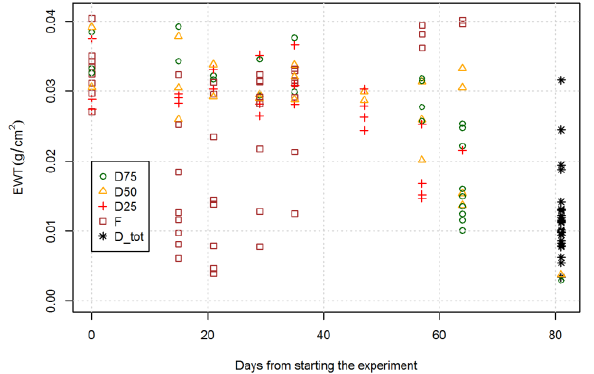
Figure 1. Equivalent water thickness (EWT) in the treatment groups during the experiment.